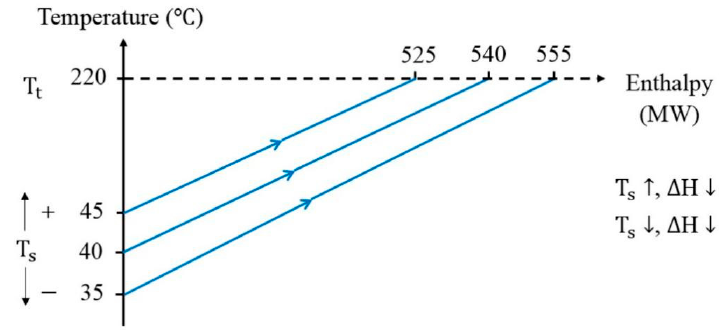
Figure 4. Effect of increasing or decreasing T S on a cold stream.